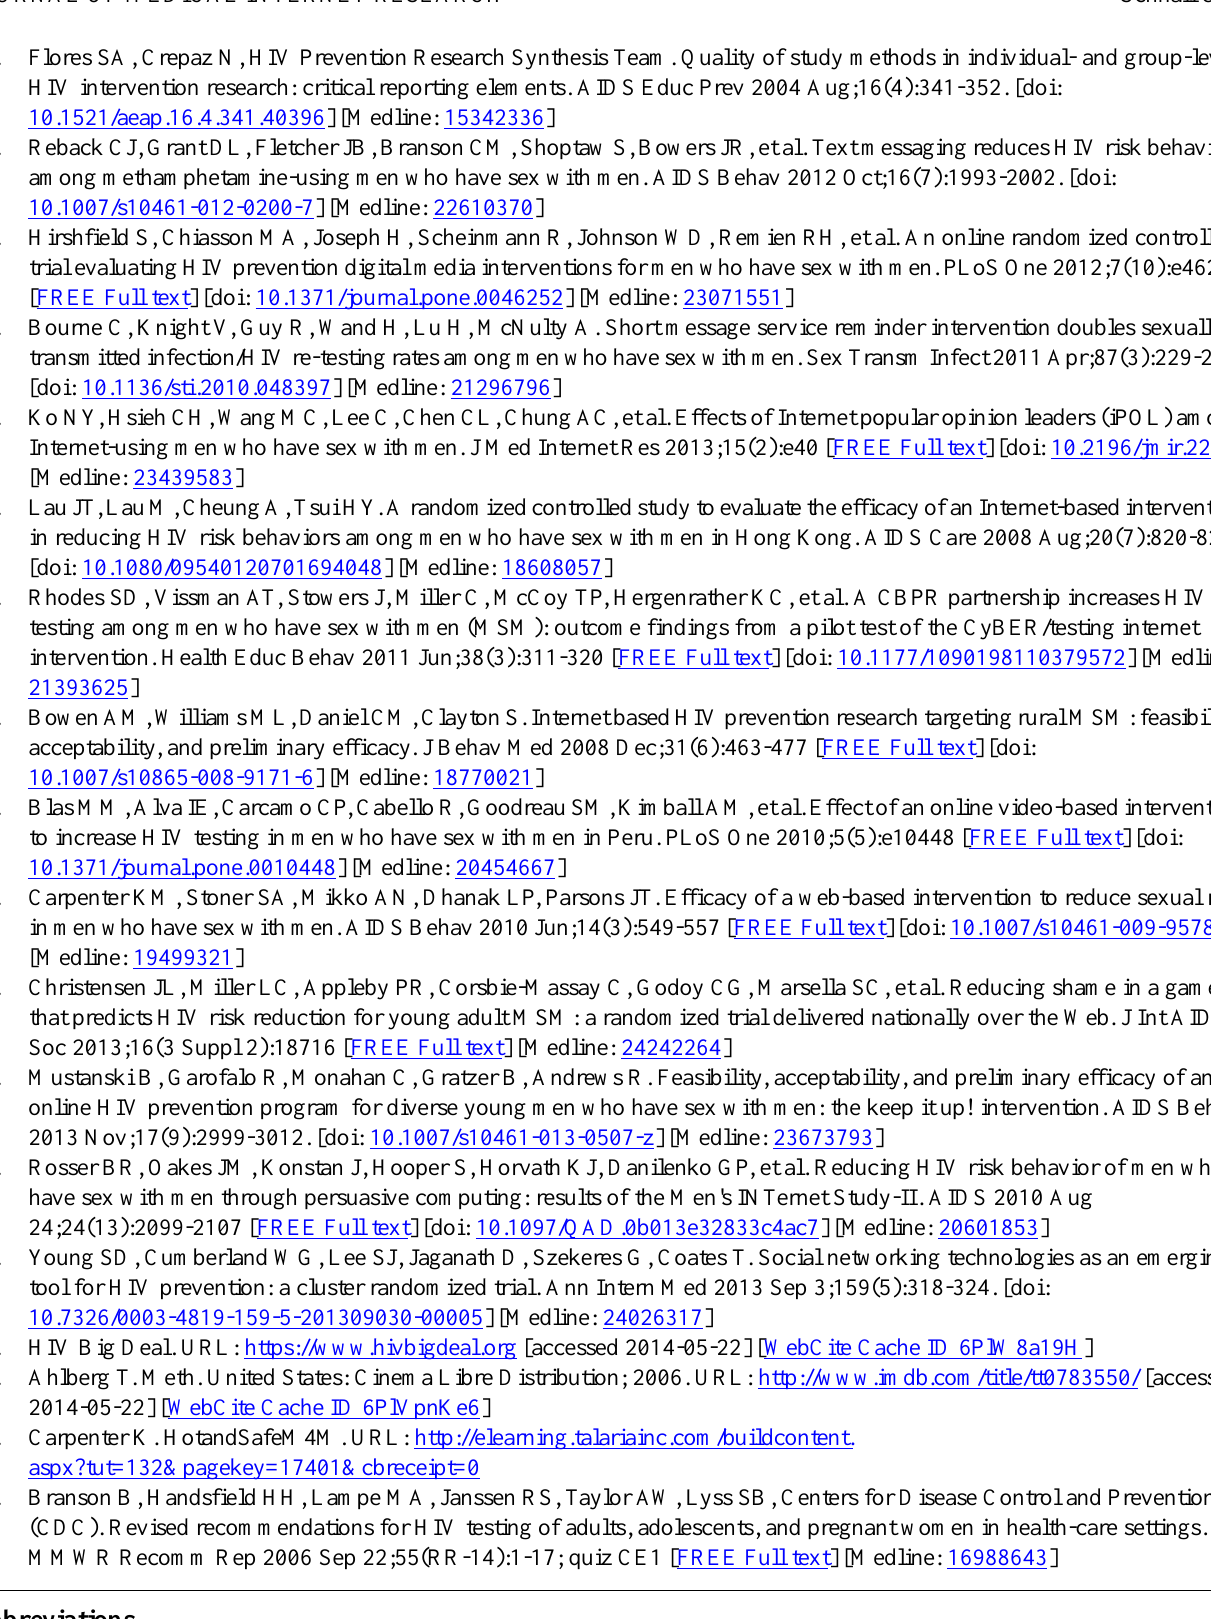
AIDS: acquired immunodeficiency syndrome CDC: Centers for Disease Control and Prevention HIV: human immunodeficiency virus IMB: Information-Motivation-Behavioral Skills